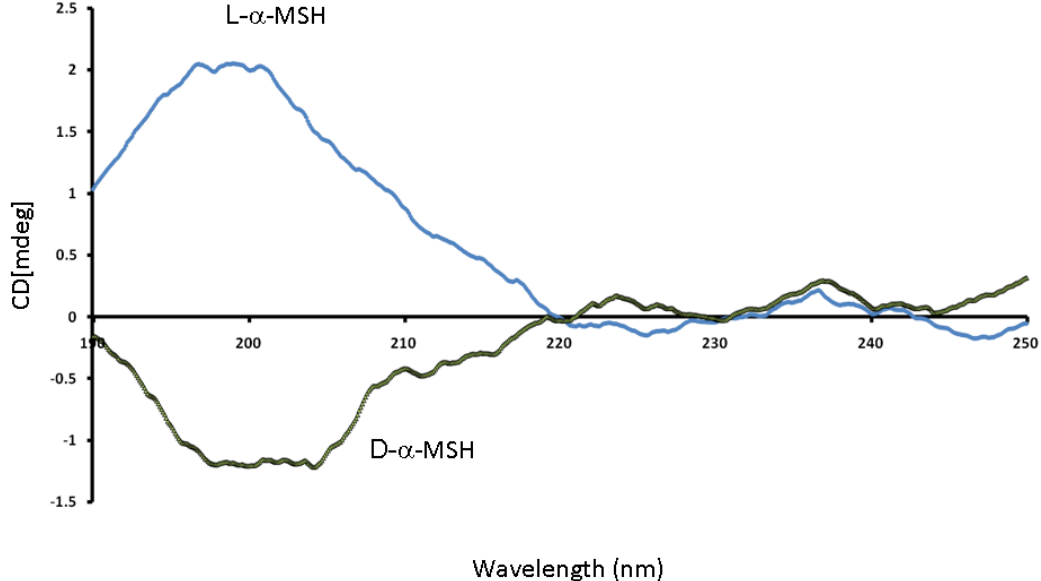
Figure 2. CD spectra of L - α -MSH and D - α -MSH enantiomers (10 mM, pH 7.4, sodium phosphate buffer at peptide concentration of 0.1 mM).